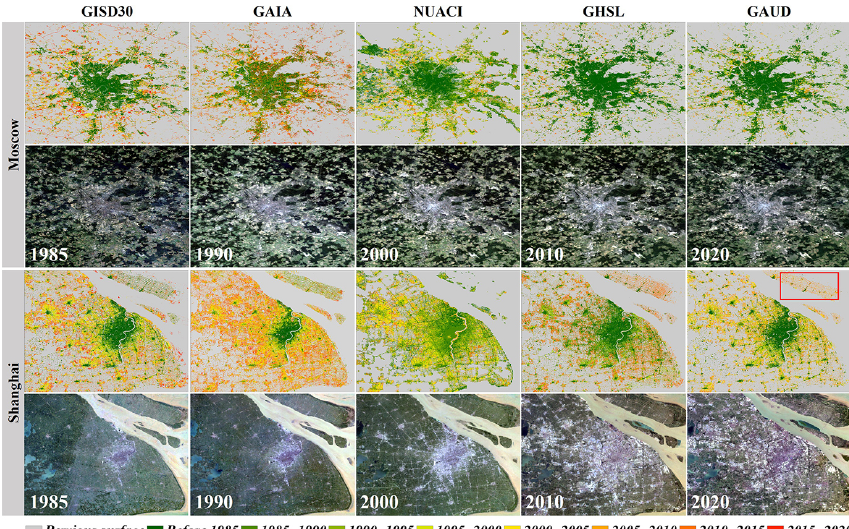
Figure 12. Comparisons between the GISD30 dynamic products and four other datasets (the GAIA products developed by Gong et al., 2020; NUACI developed by Liu et al., 2018; GHSL developed by Florczyk et al., 2019; and GAUD developed by X. Liu et al., 2020) in the two representative megacities of Moscow and Shanghai. In each case, the multi-epoch Landsat imagery, comprised of red, green and blue bands, came from the United States Geological Survey (https://earthexplorer.usgs.gov/, last access: 13 April 2022).